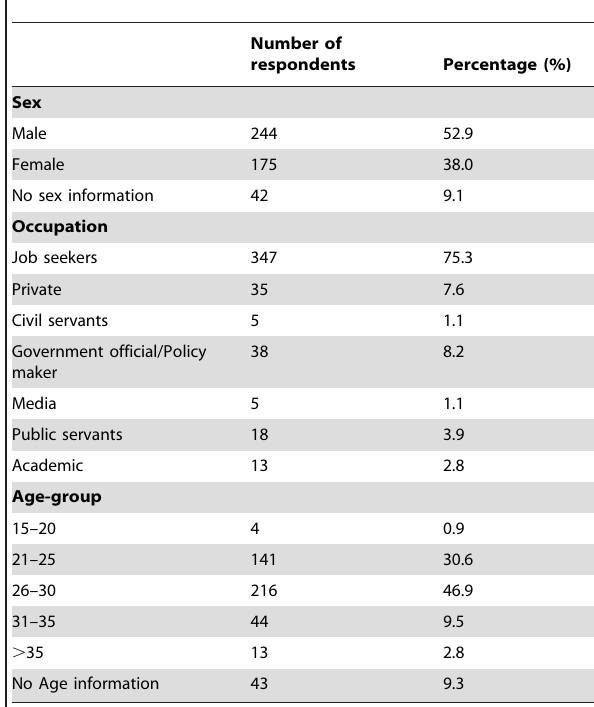
Table 1. Demographic characteristics of